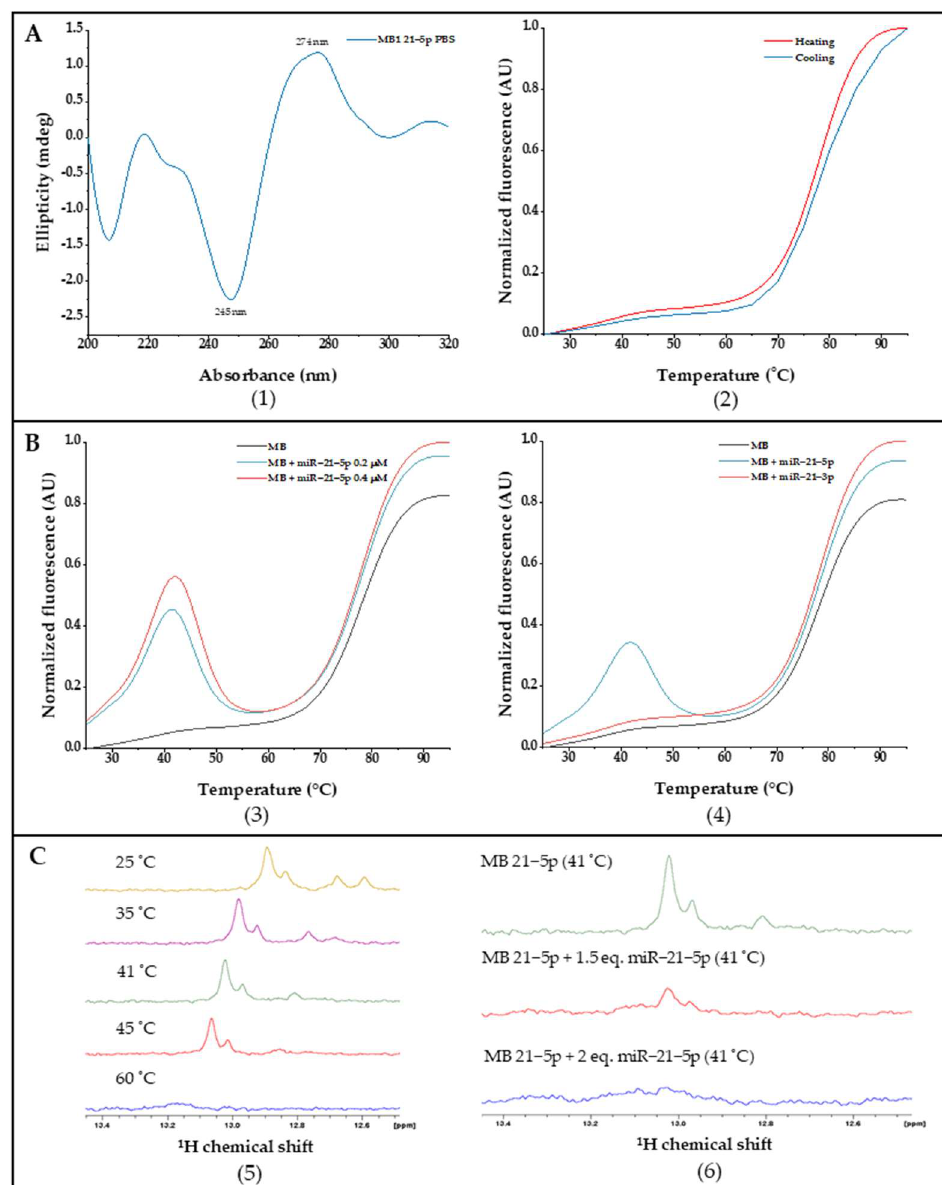
Figure 3. ( A ). (1) CD spectra of MB 21-5p in PBS; (2) MB 21-5p FRET and reverse FRET melting curves normalized to [0, 1]. ( B ). MB 21-5p FRET and reverse FRET melting curves with (3) specific miR-21-5p and (4) non-specific miR-21-3p normalized to [0, 1]. ( C). 1 H NMR spectra of (5) MB 21-5p with temperature variation and (6) MB 21-5p with miR-21-5p at the optimal hybridization temper-